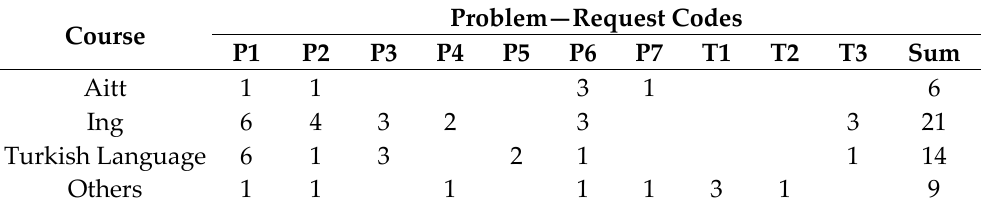
Table 5. Distribution of support request codes according to the related